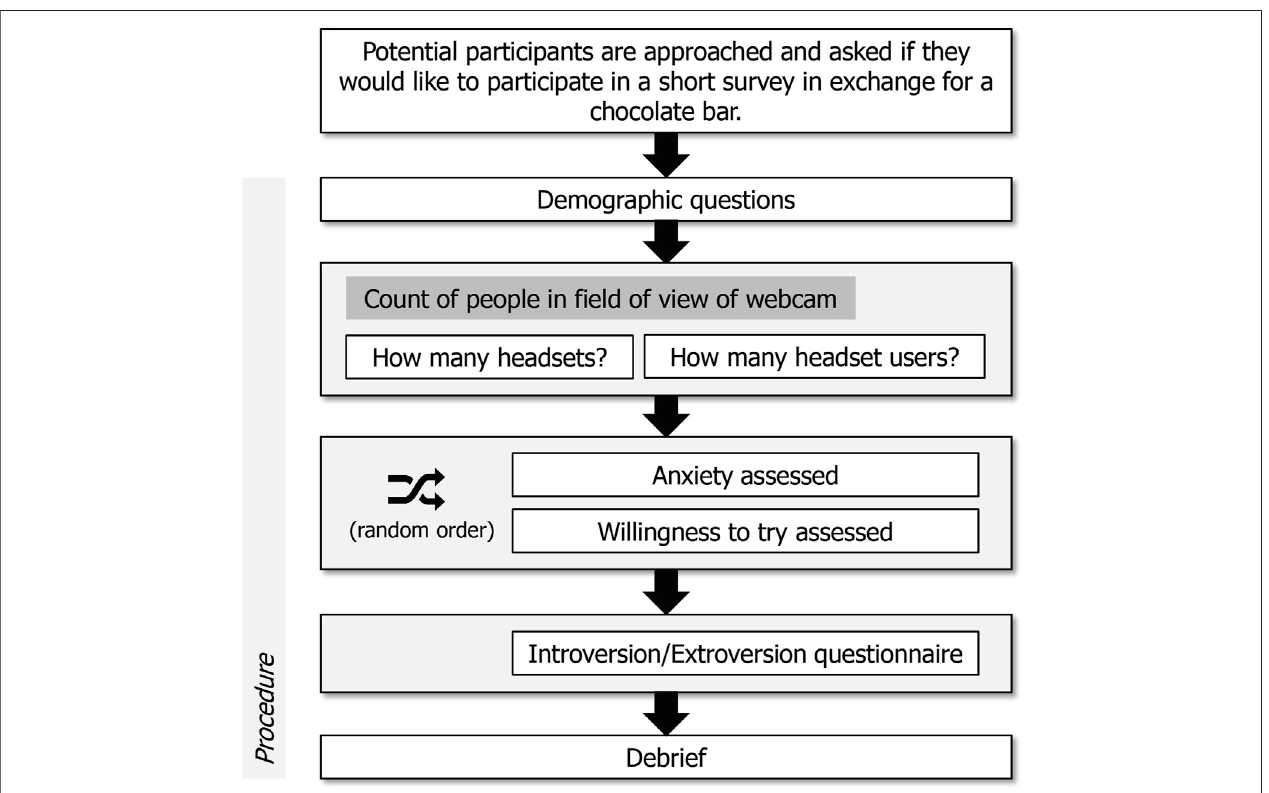
FIGURE 10 | illustrating the study design and procedure. All participants were asked to answer all questionnaire-based questions. Participants had to count the number of headsets and the number of participants currently using those headsets (black-dashed boxes). The busyness of the foyer (grey box) was also recorded.